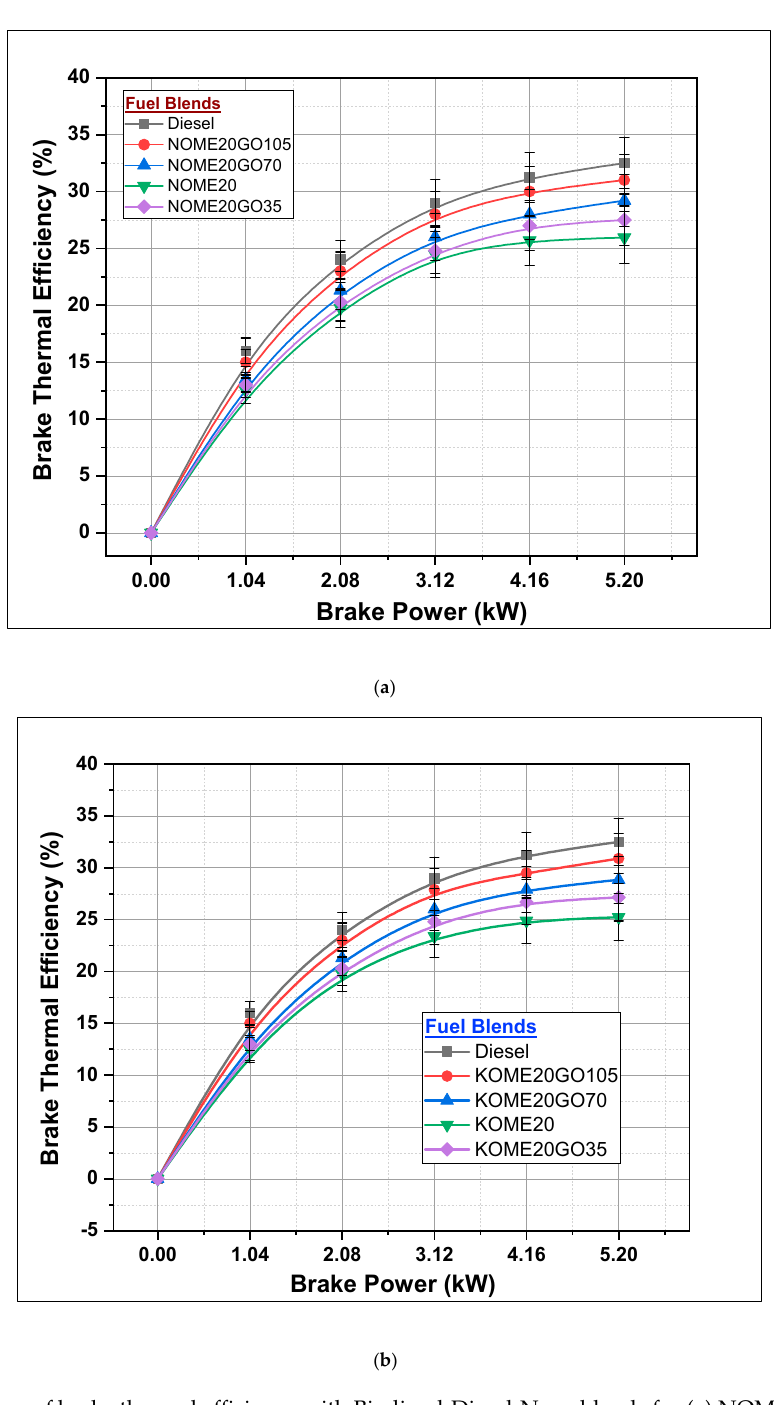
Figure 10. Variation of brake thermal efficiency with Biodiesel-Diesel-Nano blends for (a) NOME20 (b) KOME20.